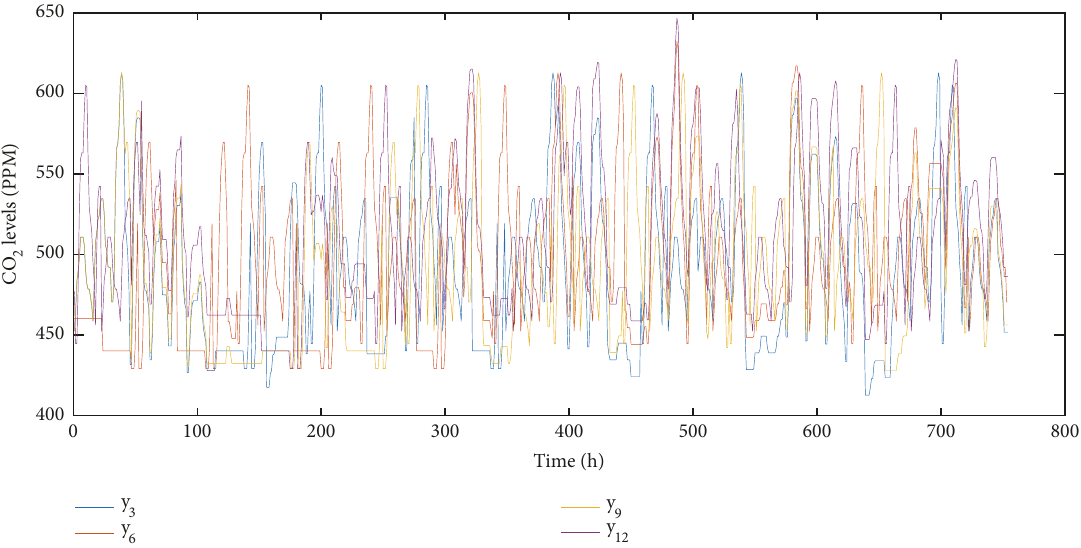
Figure 19: A CO 2 level of